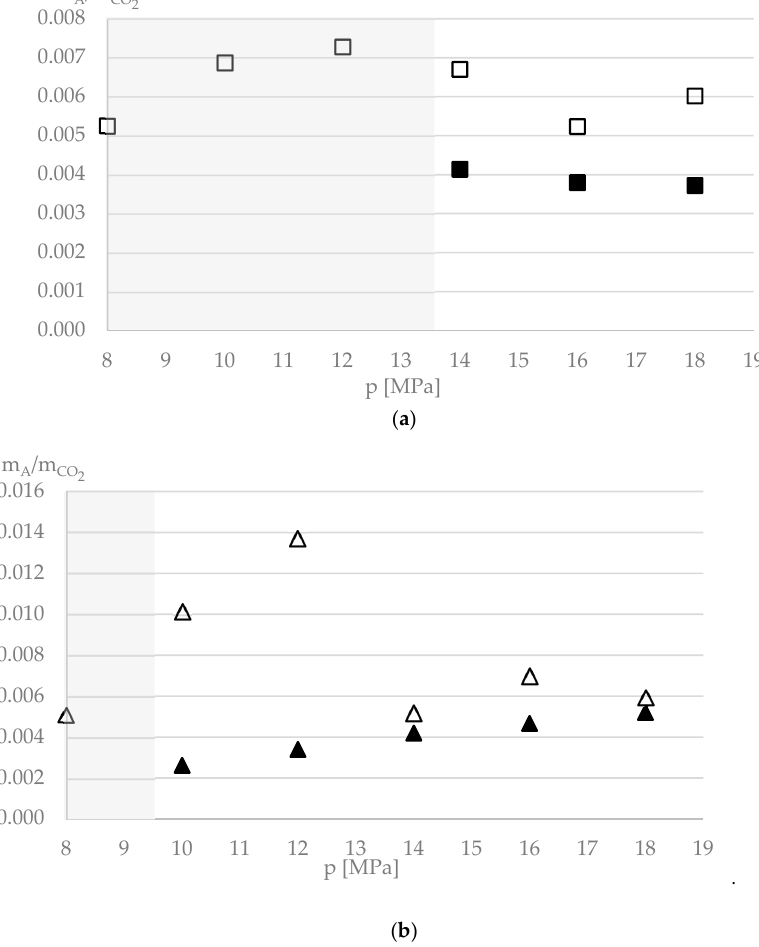
Figure 5. The relative amount of water vs. diol (m A ) in the gas phase of the quaternaries ( a ) (CO 2 + 1,4-BDO + [hmim][B(CN) 4 ] + H 2 O) or ( b ) (CO 2 + 1,2-PDO + [hmim][B(CN) 4 ] + H 2 O) systems at 313.2 K; ■ , 1,4-BDO and □ , H 2 O; ▲ , 1,2-PDO and ∆ , H 2 O.